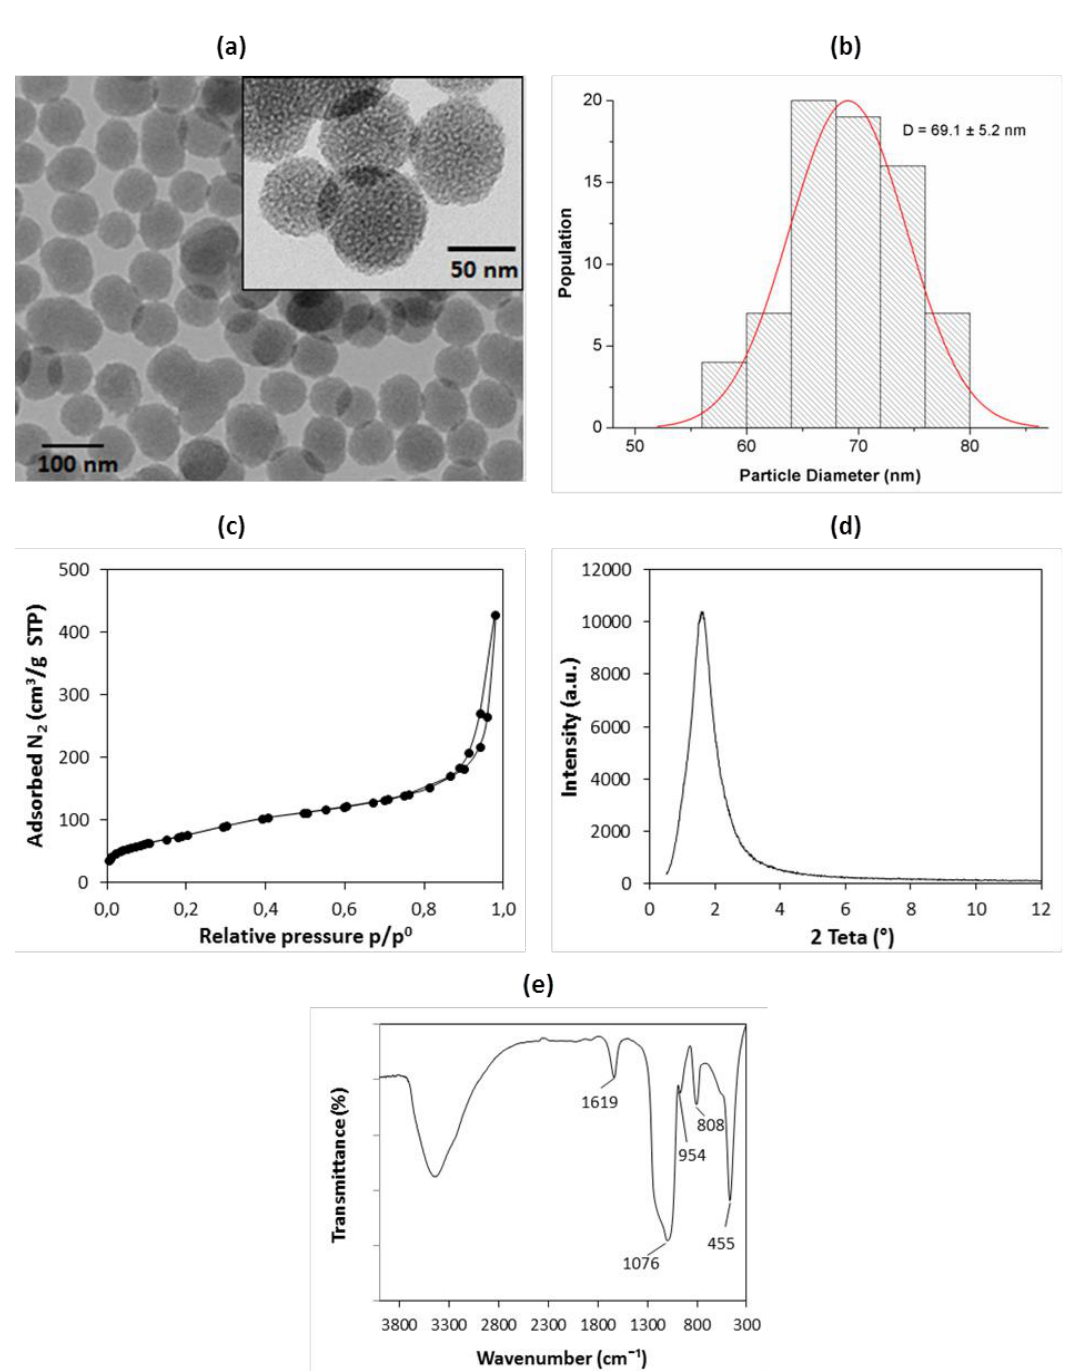
Figure 1. Physicochemical characterization of mesoporous silica nanoparticles (MSNs). ( a ) TEM micrographs (inset—high magnification); ( b ) histogram of particle size distribution; ( c ) N 2 adsorption–desorption isotherms at 77 K; ( d ) low angle XRD diffraction pattern; ( e ) FTIR spectrum with main bands identified.